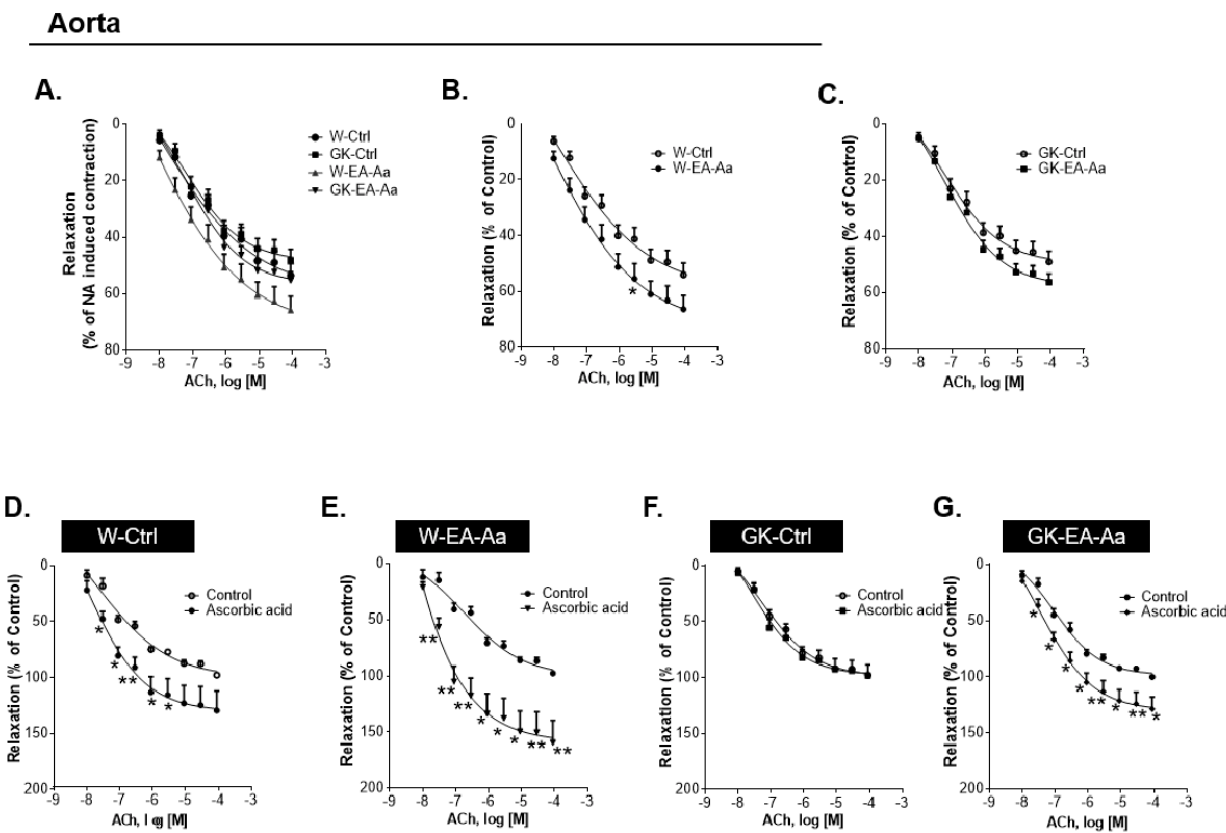
Figure 5. Increased isometric relaxation of aorta promoted by EA-Aa ( n = 5-7). Vascular relaxation of NA-precontracted aorta in response to Ach: ( A ) both strains, control and treated rats. ( B ) Wistar group; treatment with EA-Aa shows a light increase in aorta relaxation compared to W-Ctrl. ( C ) GK group. Aorta pre-incubated with ascorbic acid: ( D ) W-Ctrl; an increase in aorta relaxation promoted by ascorbic acid is evident in pre-incubated W-Ctrl. ( E ) W-EA-Aa; treatment with EA-Aa increased the relaxation in normal rats in comparison to the non-pre-incubated group. ( F ) GK-Ctrl. ( G ) GK-EA-Aa; EA-Aa induces an improvement in aorta relaxation in comparison to the non-pre-incubated aorta in diabetic rats. * vs. the same point with or without ascorbic acid pre-incubation; * p < 0.05; ** p < 0.01.